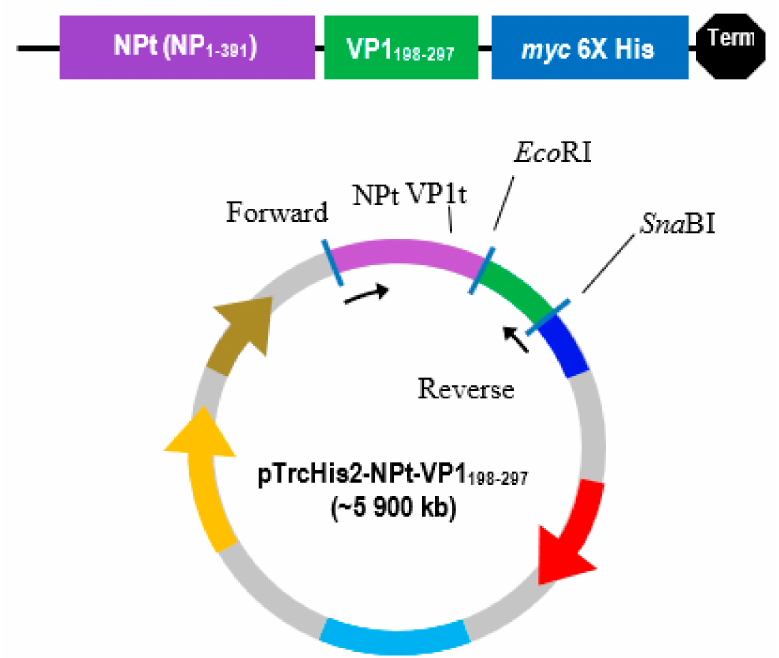
Figure 3. Schematic representation of the pTrcHis2 plasmid carrying a truncated nucleocapsid protein (NPt) gene of Newcastle disease virus (NDV) fused with the VP1 198–297 gene of EV71. The gene fragment of VP1 198–297 was synthesized by Polymerase Chain Reaction (PCR) and inserted at the C-terminal of NPt